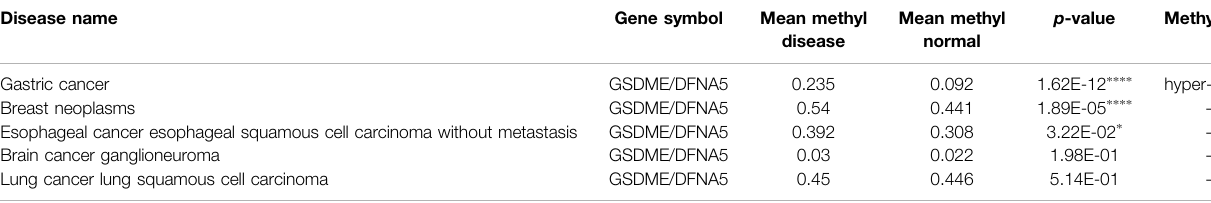
TABLE 2 | Association between disease and methylation of GSDME/DFNA5. Disease